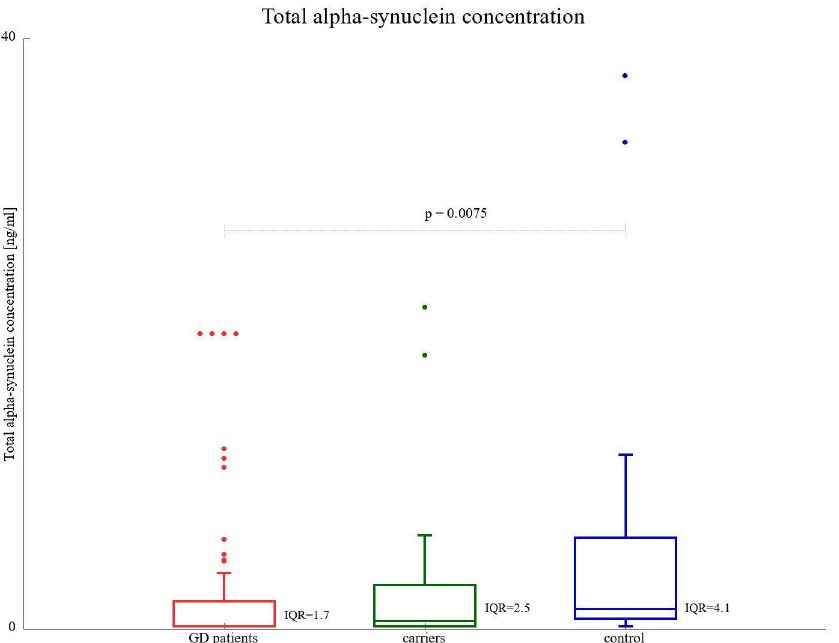
Figure 3. Total α -SNCA protein level (ng/mL) among GD1 and GD3 patients compared to GBA1 mutation carriers and healthy control subjects. IQR represents the interquartile range.